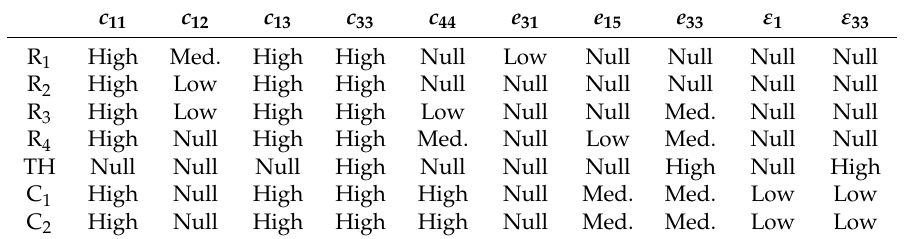
Table 3. Summary of the sensitivity analysis from Figure 4 and similar in the supplementary material.